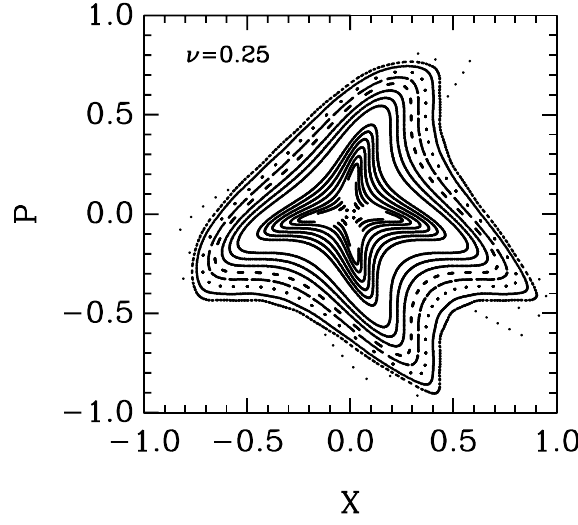
FIG. 6. Phase-space portrait of the Hénon map for n (cid:173) (cid:49)